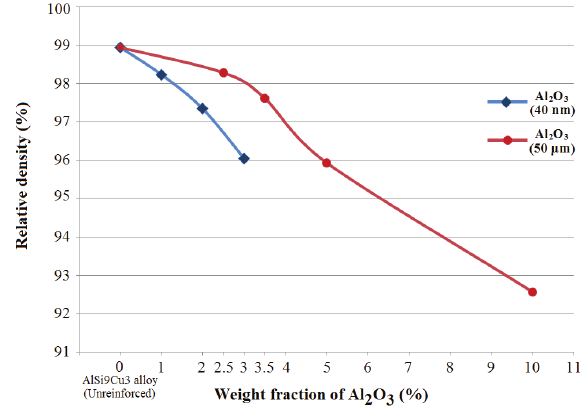
Cu alloy and the 9 3 O 2 3